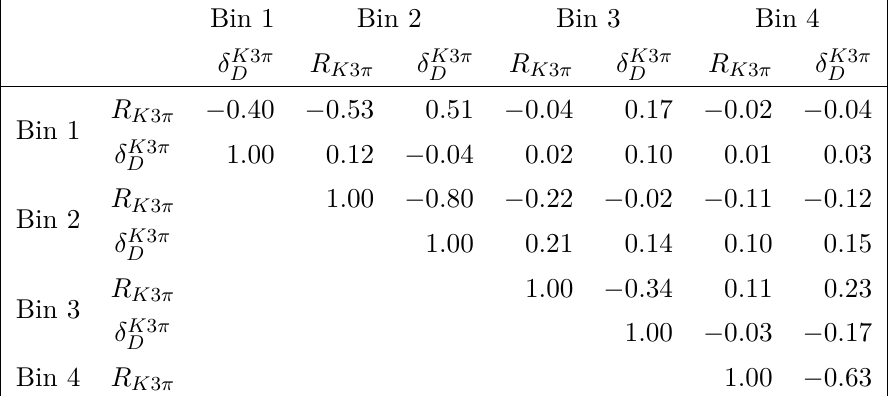
Table 22 . Correlation matrix for the hadronic parameters from the binned fit to the BESIII and CLEO-c